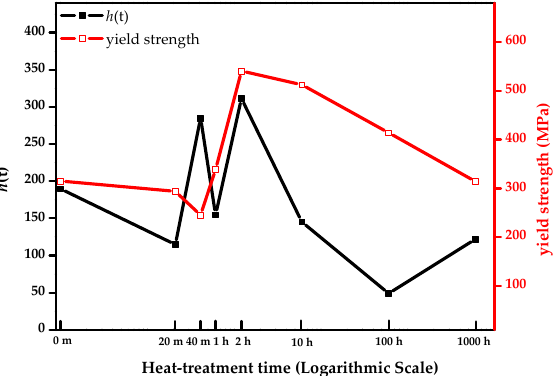
Figure 7. Dependence on the heat-treatment time of the measured parameter of hysteretic quadratic nonlinearity, ℎ , and of the yield strength (adopted from Reference [56]).